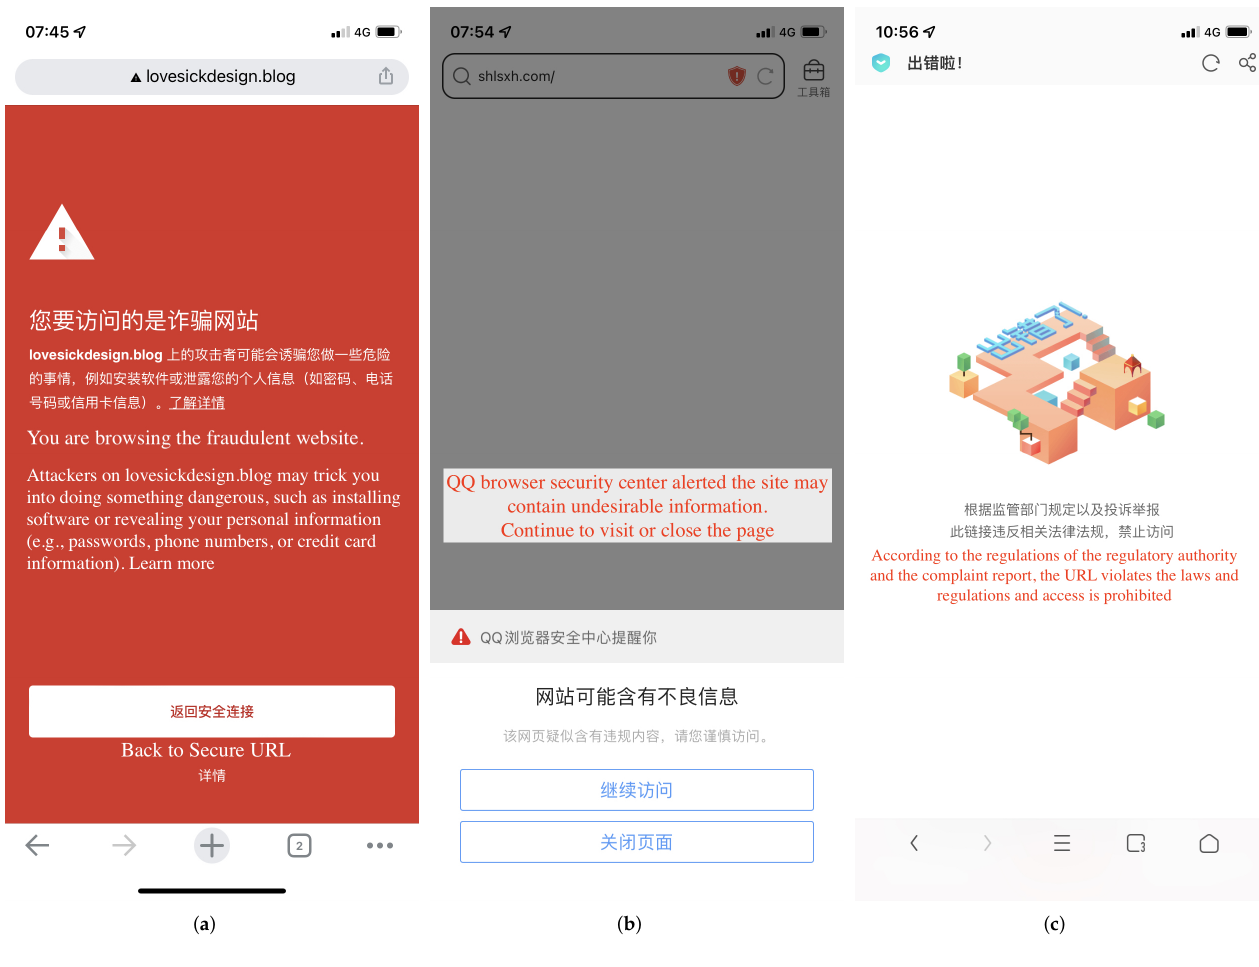
Figure 3. Browsers warn or block users from accessing abusive domains. ( a ) Google Chrome. ( b ) Tencent QQ Browser. ( c ) UC Browser.